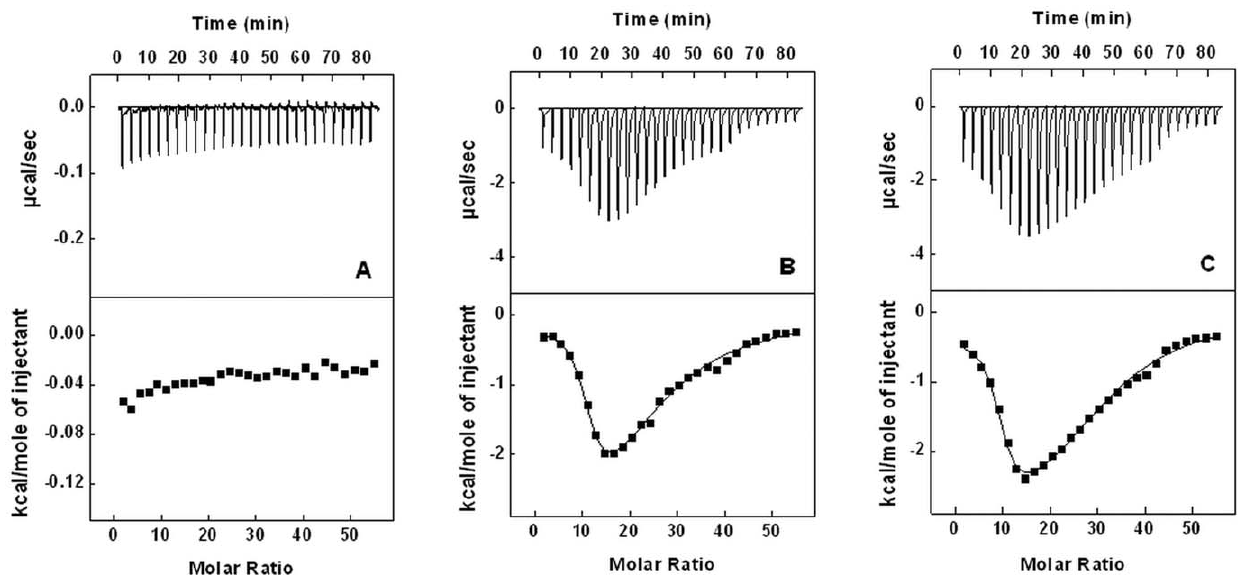
Figure 7. Isothermal titration calorimetery. Plot of enthalpy change against molar ratio for the titration of ANS with chymopapain at (A) pH 7.4 (B) pH 1.5 and (C) pH 1.0. The upper panels represent the raw data and the bottom panels are the non-linear best fit data. Protein concentration was